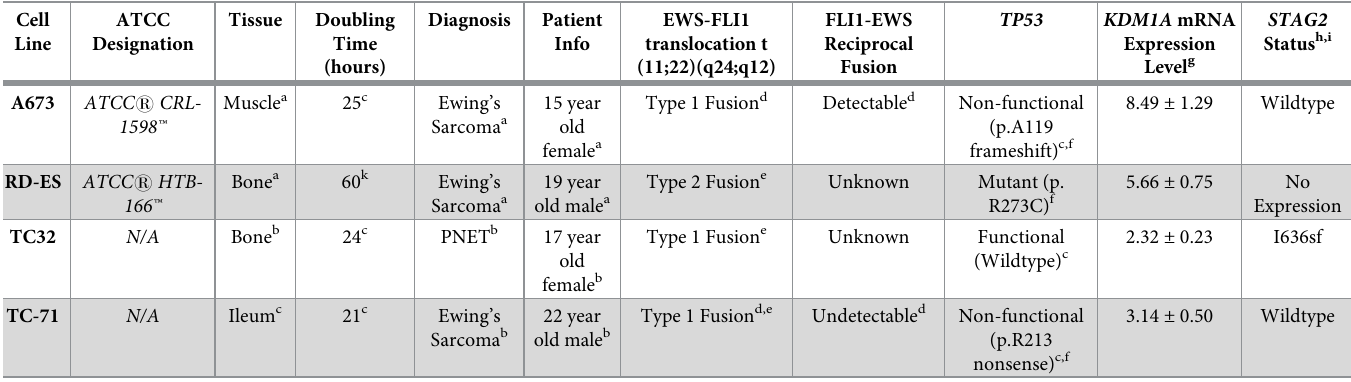
Table 2. Summary of Ewing cell